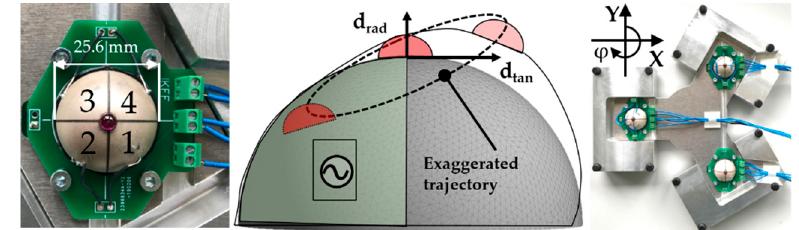
Figure 1. Hemispherical piezoelectric shell resonator for a planar motor (bottom view).